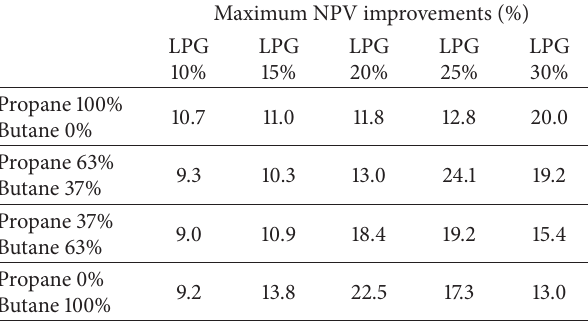
Table 7: Maximum NPV improvements with LPG mole fraction and composition for oil-wet reservoir (base case: $2,652,887).